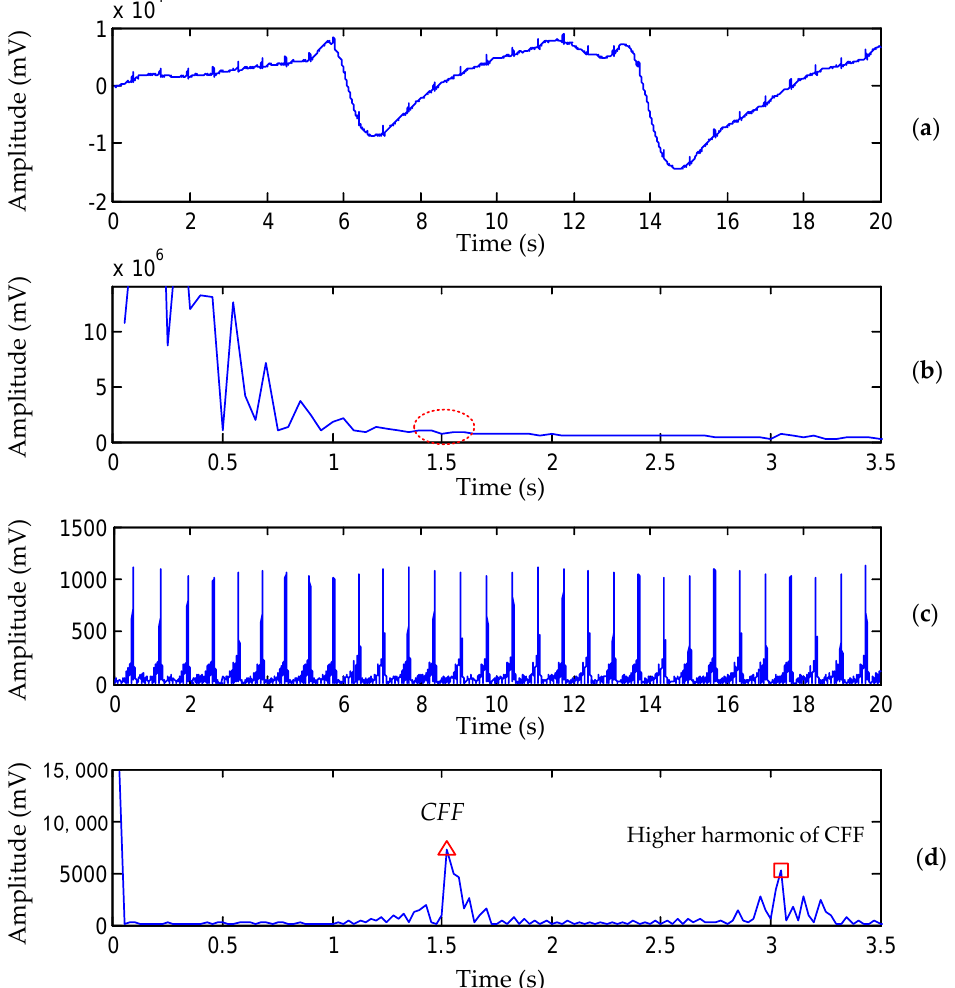
Figure 1. Comparison of CFF detection by the previous method [20] and the proposed method (PTB record s0130lrem, lead I, 00:00 − 00:20). ( a ) Raw ECG signal contaminated with severe BW. ( b ) Amplitude of raw ECG in the Fourier domain. ( c ) Waveform of the extracted QRS complexes (cid:12) x QRS ( n ) (cid:12) . ( d ) Amplitude of (cid:12) x QRS ( n ) (cid:12) in the DCT domain, the red ‘triangle’ and red ‘square’ denote the position of CFF and its higher harmonic, respectively